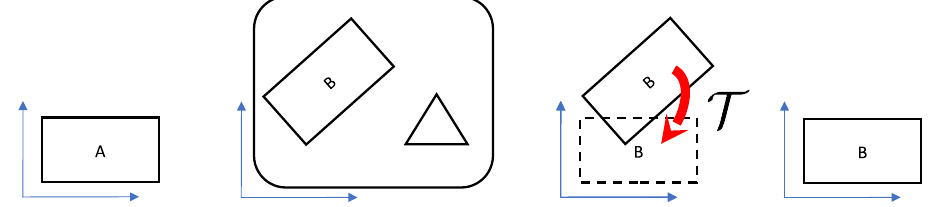
Figure 1. The objects recognition and alignment tasks. From left to right: template, scan, the recognized object with transform, the aligned object (top view of 3D